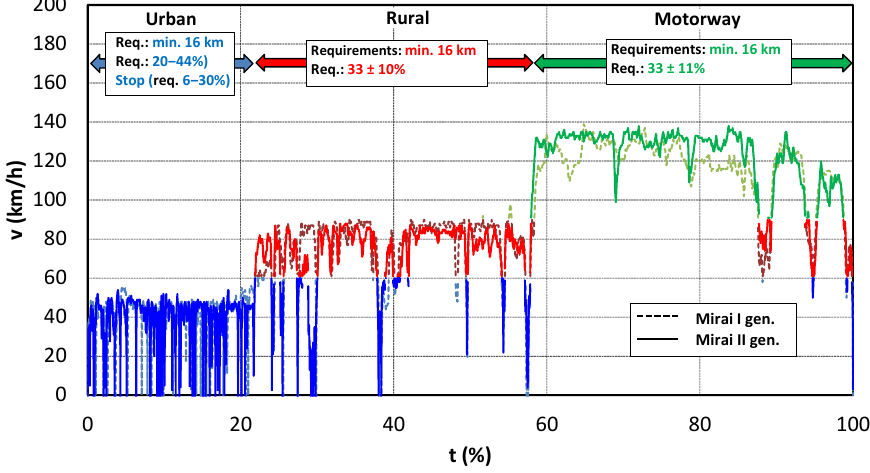
Figure 11. Research test results in accordance with the RDC requirements.